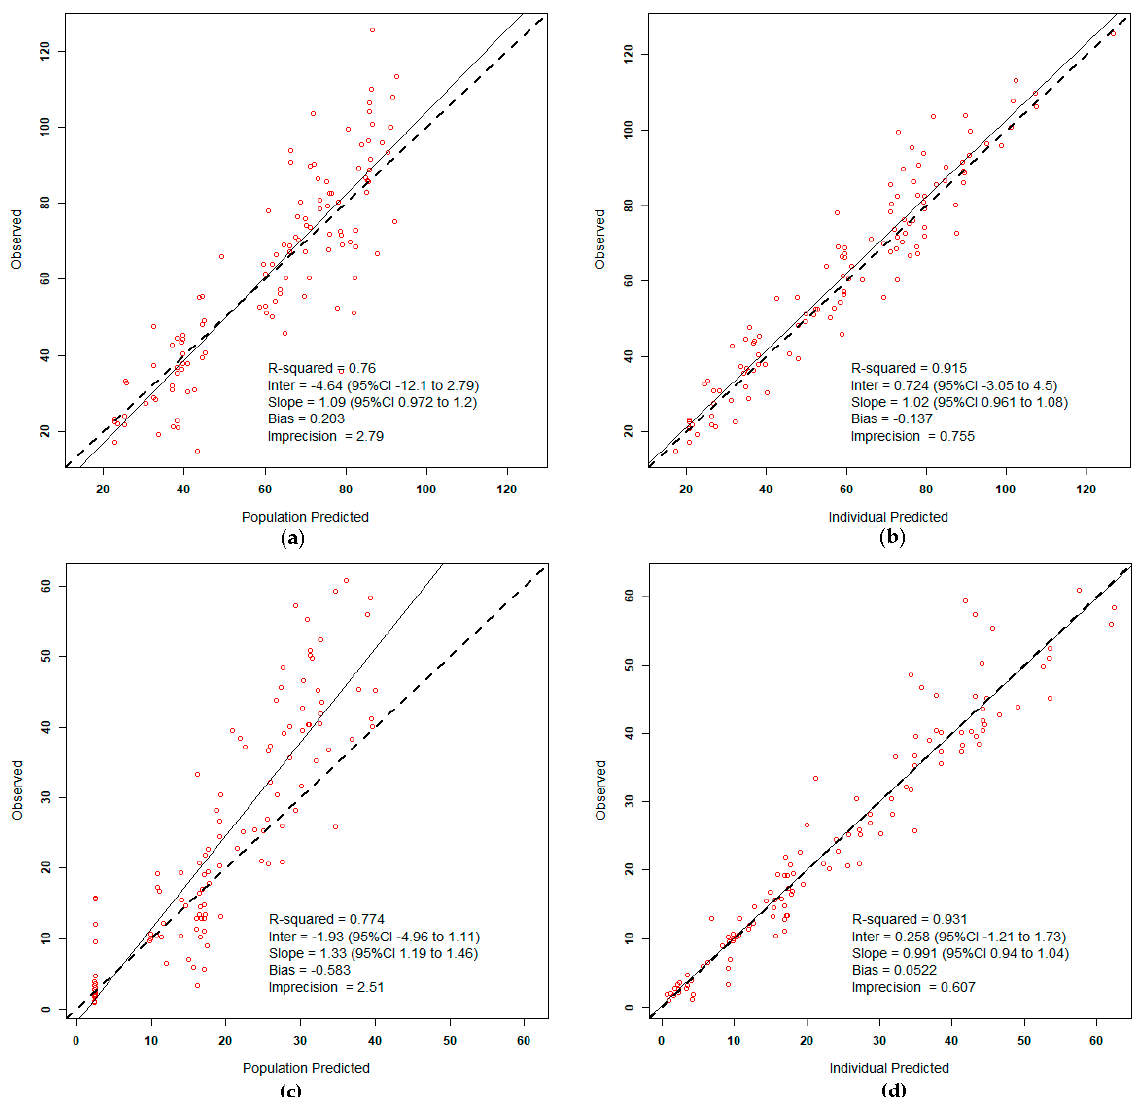
Figure 2. Scatter plots showing observed-versus-predicted values for the population PK model after the Bayesian step. The different panels show the population predicted concentrations in plasma ( a ) and ascitic fluid ( c ), and the individual posterior predicted concentrations in plasma ( b ) and ascitic fluid ( d ).